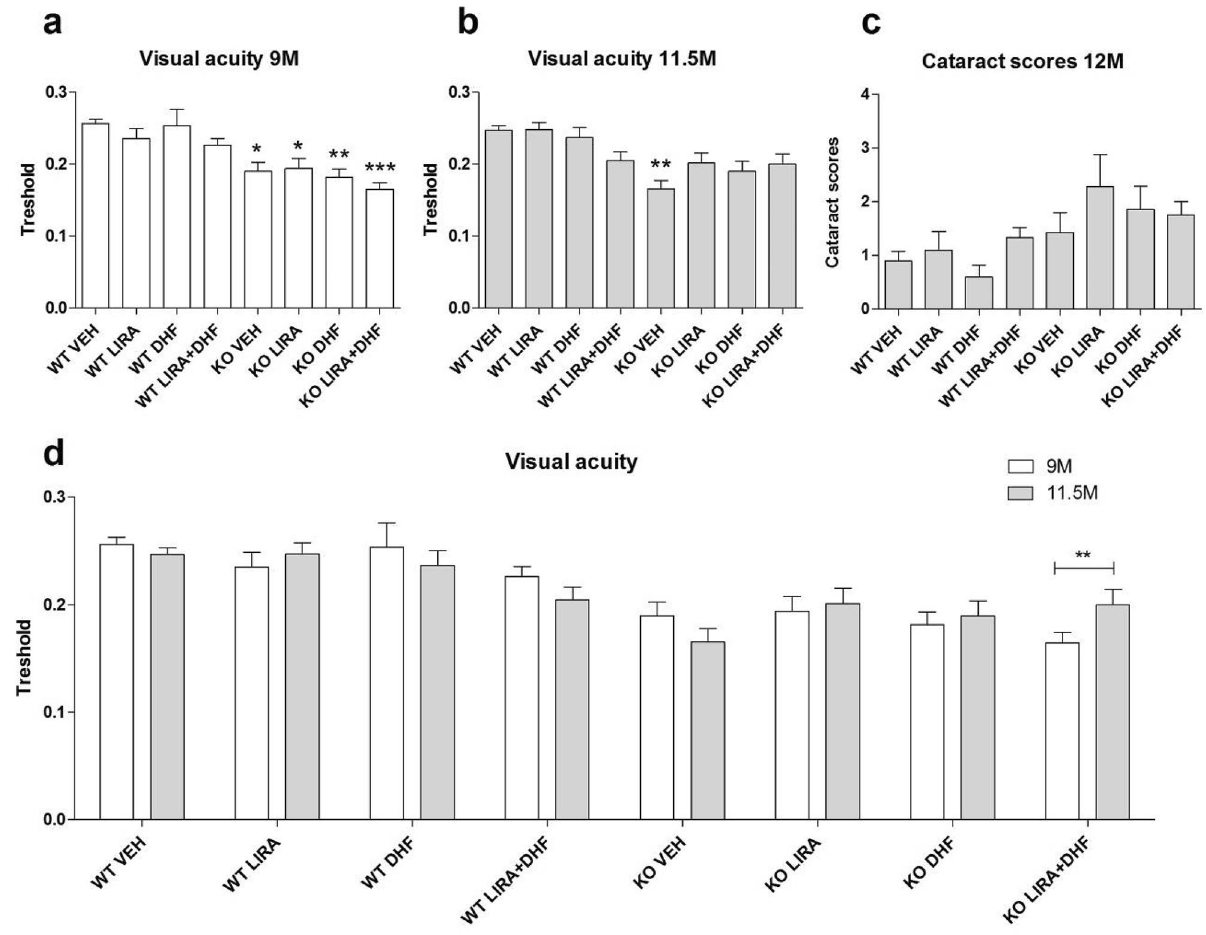
Figure 2. Visual acuity in liraglutide (LIRA), 7,8-DHF (DHF) and liraglutide in combination with 7,8-DHF (LIRA + DHF) treated WT and Wfs1 KO rats. ( a ) Optokinetic reflex response at the age of 9 months, ( b ) 11.5 months. Optokinetic response was measured for both eyes and data is averaged. ( a ) At the age of 9 months, Wfs1 KO VEH animals’ visual acuity was lower compared to WT VEH animals. ( b ) After 2.5 months Wfs1 VEH animals condition worsened, while Wfs1 KO animals treated with liraglutide or 7,8-DHF stayed at the same level. ( c ) Cataract scores at the age of 11.5 months. ( d ) Visual acuity repeated measures, liraglutide in combination with 7,8-DHF (LIRA + DHF) improved Wfs1 KO animals’ visual acuity. The data were compared using one-way or repeated measures ANOVA followed by Bonferroni post hoc tests; *p < 0.05; **p < 0.01; ***p < 0.001 compared to WT vehicle treated animals. The data are presented as the mean ± SEM, n = 5–8 per 7,8-DHF sifted the size distribution to WT animals levels, whereas axon calibers larger than 3 μm 2 could not be rescued. Optic nerve fiber consists of axon and of the surrounding myelin sheath. To evaluate area-based g-ratio, both the axon area and the surrounding myelin area were measured. Optic nerve axons area per field of view (FOV) was most drastically decreased in vehicle treated Wfs1 KO rats (p < 0.001) (Fig. 3j). Treatment with liraglutide, 7,8-DHF or their combination prevented such decrease (p < 0.05). Moreover, Wfs1 KO rats treated with the com- bination of liraglutide and 7,8-DHF showed increased axon area per FOV compared to vehicle treated Wfs1 KO animals (p < 0.05) (Fig. 3j). Myelin area per FOV was not changed between groups (Fig. 3k). Area based g-ratio (axon area divided by axon area plus myelin area) was lower in vehicle treated Wfs1 KO rats compared to vehicle